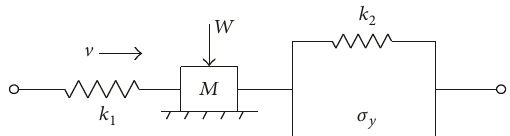
Figure 1: Mode of stick-slip fault instability in fault-slip rock